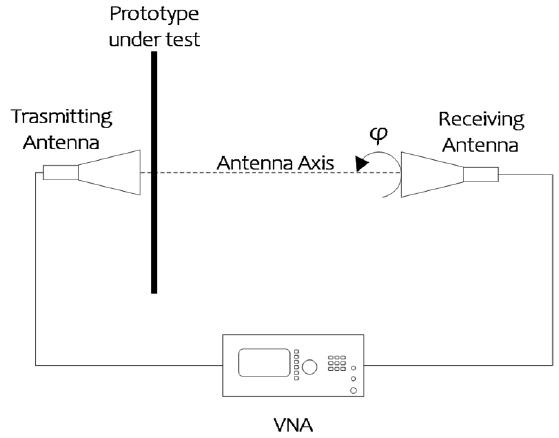
Figure 9. Block diagram of the measurement setup.